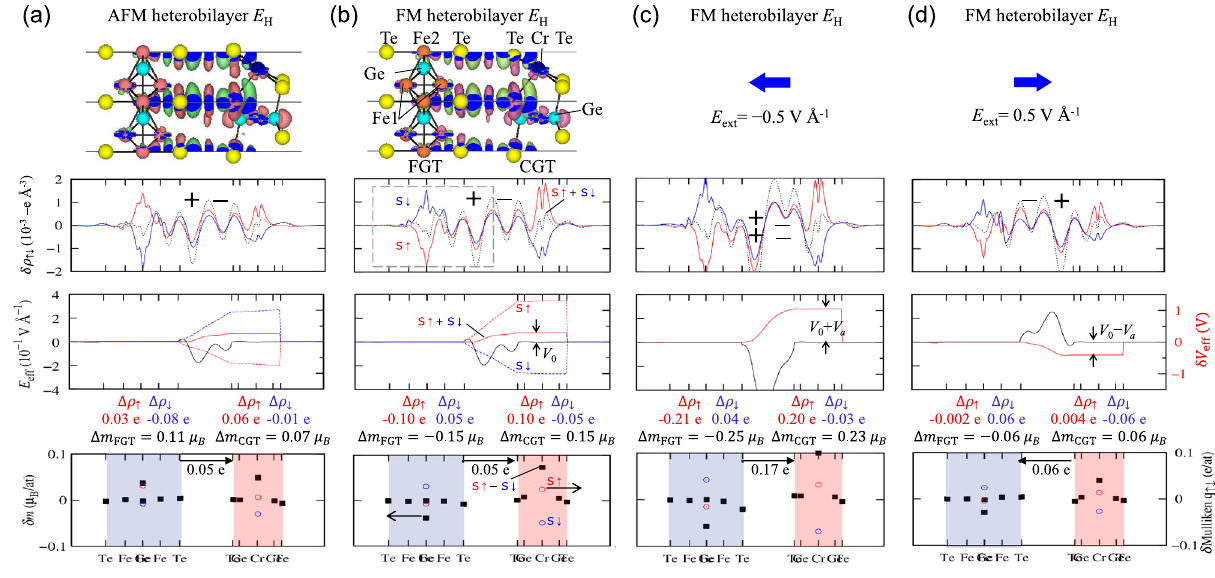
ρ HB ρ FGT ( z ) ( z ) ( z ) Figure 6. In-plane averaged spin-dependent electron density difference ( δρ , , , = − ↑ ↓ ↑ ↓ ↑ ↓ ρ CGT ( z ) , top panels), effective electric field, E , eff , effective potential difference, δ V eff (middle panels), − ↑ ↓ m FGT ( z ) m CGT ( z ) ), and spin-dependent Mulliken m HB ( z ) magnetic moment variation ( δ m ( z ) − − = electron difference (bottom panels) of ( a ) the AFM FGT/CGT heterobilayer, ( b ) FM heterobilayer, ( c ) FM heterobilayer in a − 0.5 V Å −1 negative electric field, and ( d ) FM heterobilayer in a 0.5 V Å −1 positive electric field. The x -tics represent the z -components of atomic positions. The effective electron density difference ( δρ eff ( z ) = δρ ↑ ( z ) + δρ ↓ ( z )) is indicated by black dotted lines in the top panel. On the atomic structures in ( a ) and ( b ), the effective electron density difference with electron accumulation (magenta) and depletion (green) is depicted. The + and − symbols represent the electron depletion and accumulation at the interface in the top panel, respectively. The general signs of E eff and δ V eff for the positive charge are opposite to them calculated for the electron in this study. �ρ denotes the spin-dependent total electron density difference per single ↑↓ layer in the heterobilayer, and (cid:31) m represents the total magnetic moment variation per single layer. The red and blue open circles at Fe2 and Cr atoms indicate the spin-up and spin-down Mulliken electron differences,